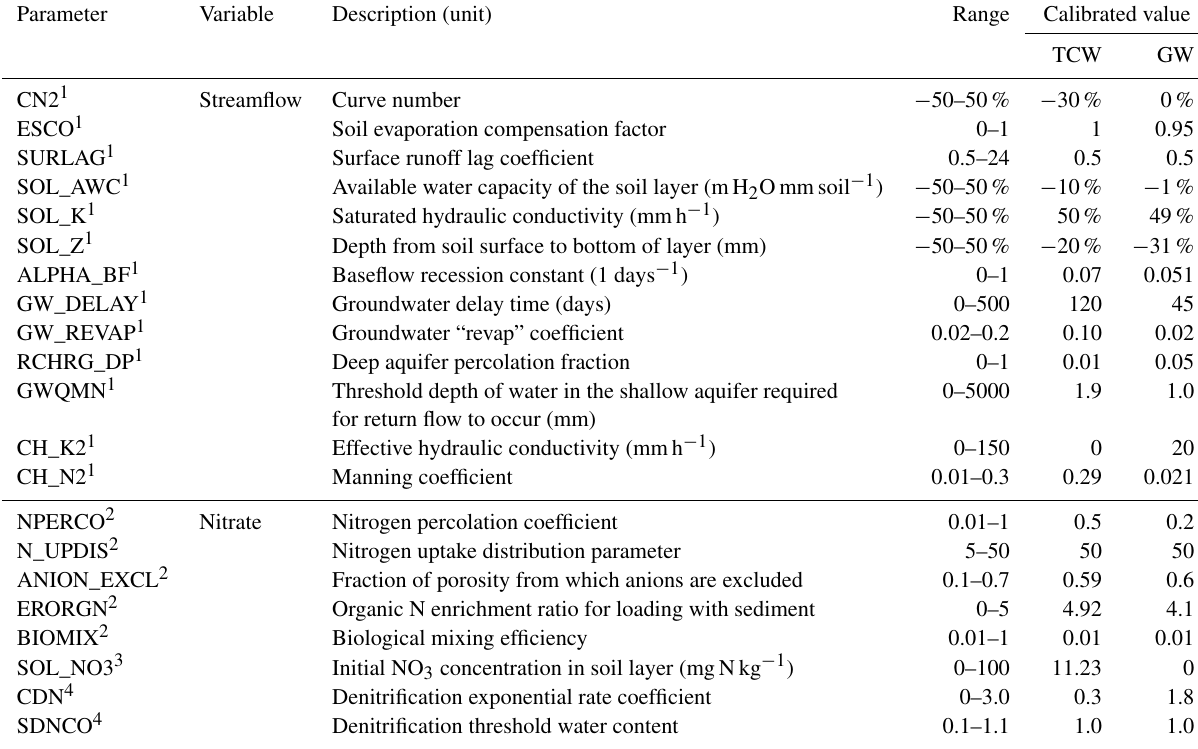
Table 3. List of calibrated